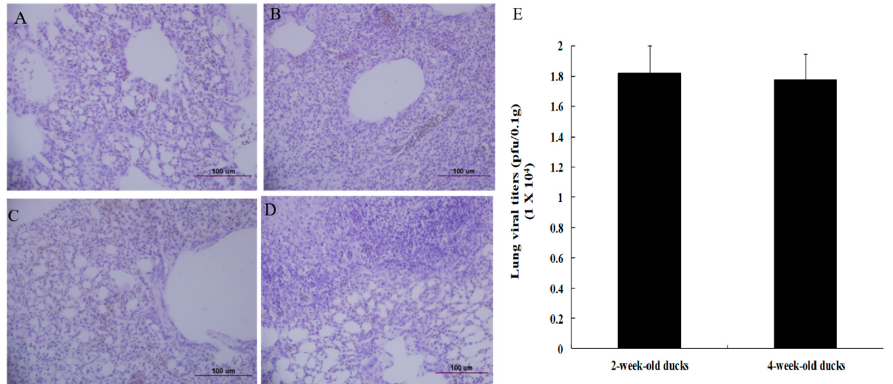
Figure 2. Viral titers and histopathology in the lungs of ducks infected with HP H5N6 avian influenza virus. Lung tissues from ducks used for viral titration were stained with H&E. ( A ) The lung tissue of uninfected 2-week-old duck, ( B ) the lung tissue of infected 2-week-old duck, ( C ) the lung tissue of uninfected 4-week-old duck, ( D ) The lung tissue of infected 4-week-old duck, ( E ) Viral titers in lungs of ducks. Ducks aged 2 or 4 weeks old were i.n. infected with 10 6 EID 50 / mL of A / Waterfowl / Korea / S57 / 2016 (clade 2.3.4.4.). The survived ducks ( n = 3 per group) were euthanized on day 3 p.i. and lung tissues were collected. The viral titers were determined by p.f.u. using MDCK